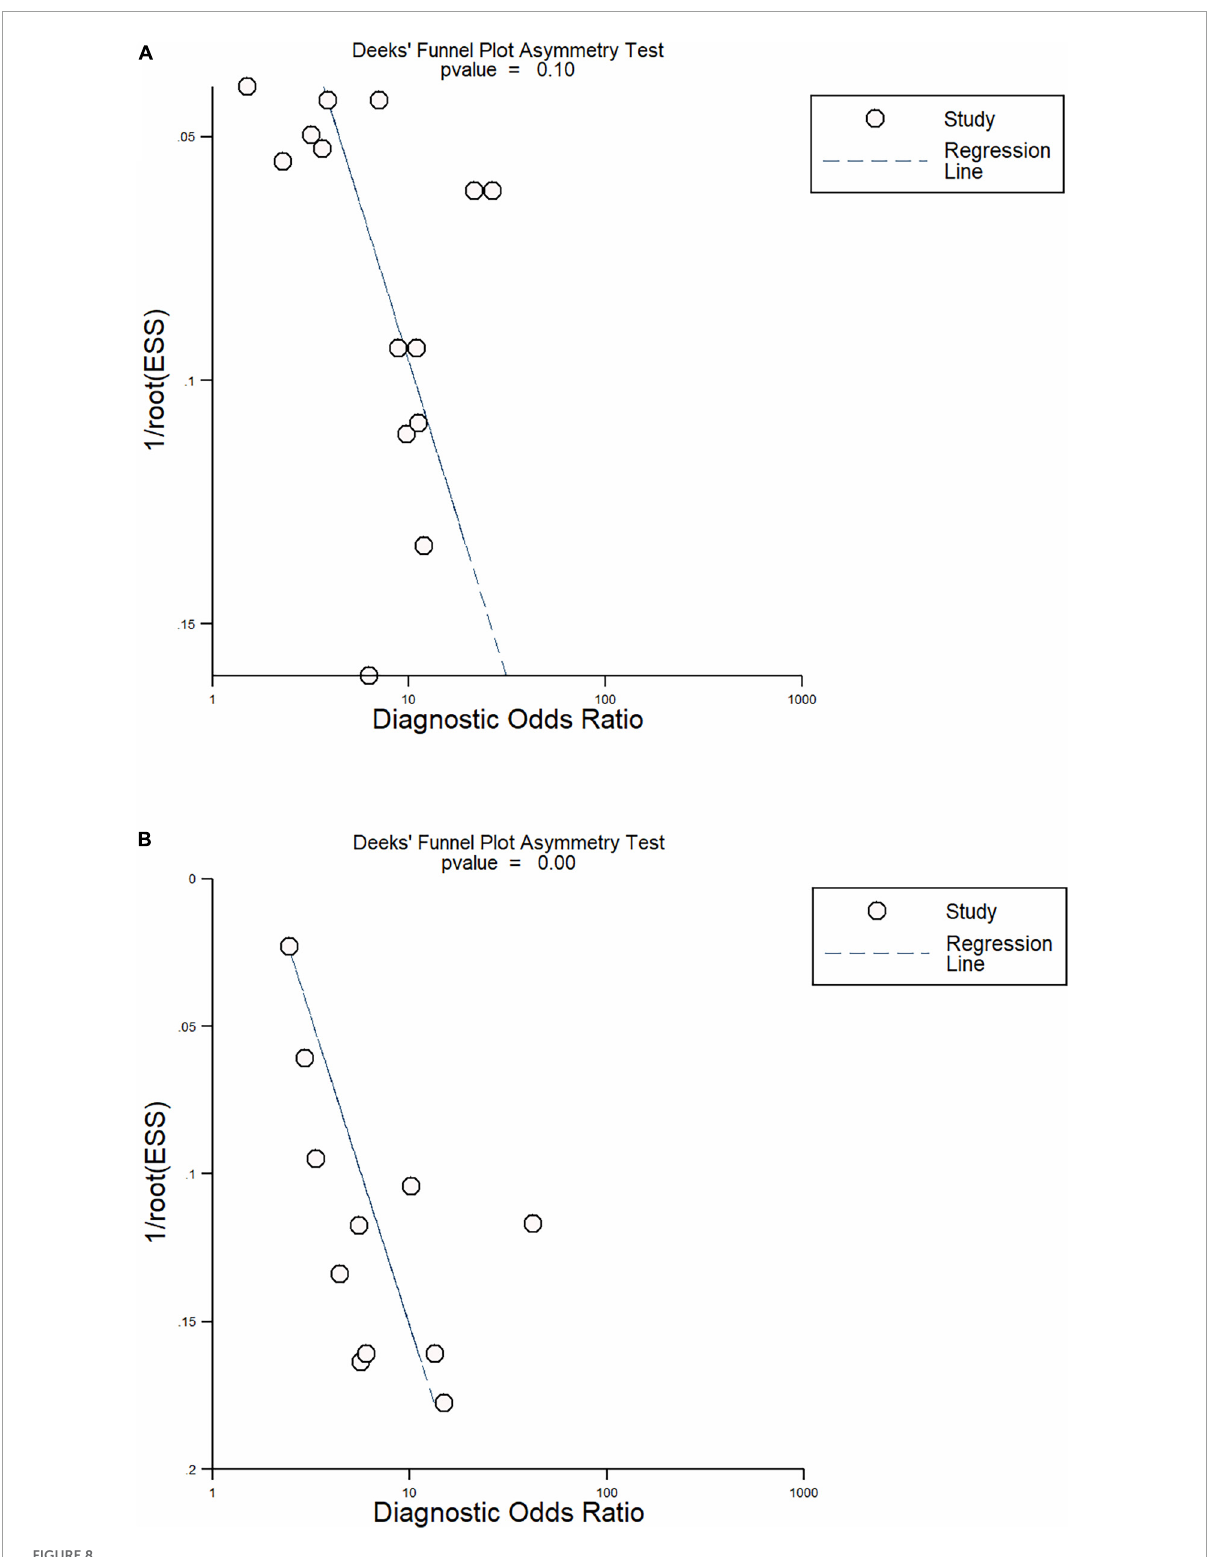
FIGURE8 Funnel plot (A) NLR; (B)